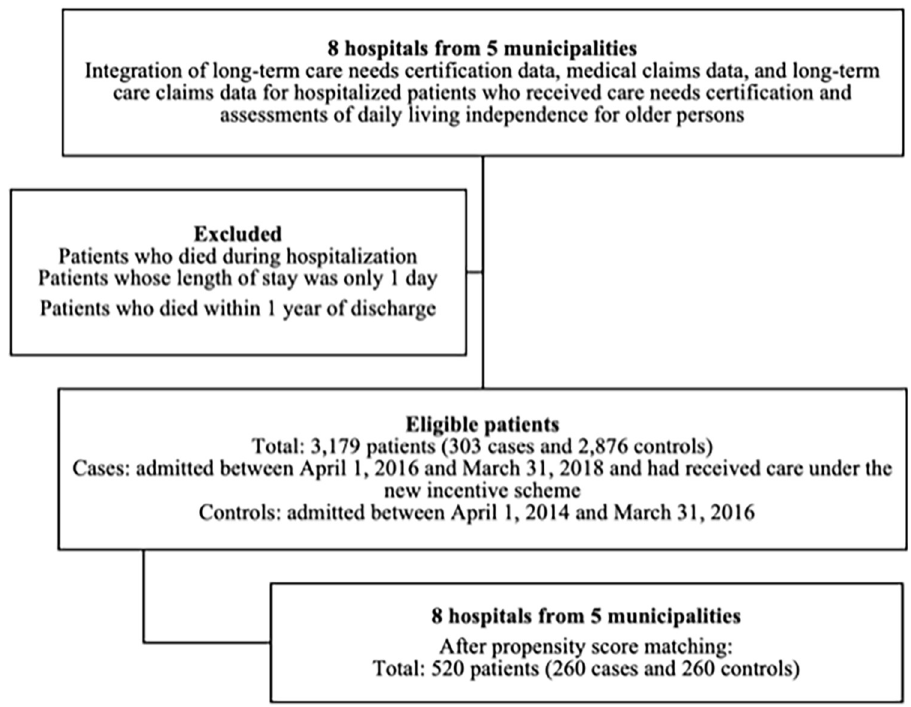
Fig 1. Patient selection process. Propensity score matching was conducted based on sex, age, Charlson Comorbidity Index score, length of stay, hospitalization expenditures, daily living independence level, and care needs level.